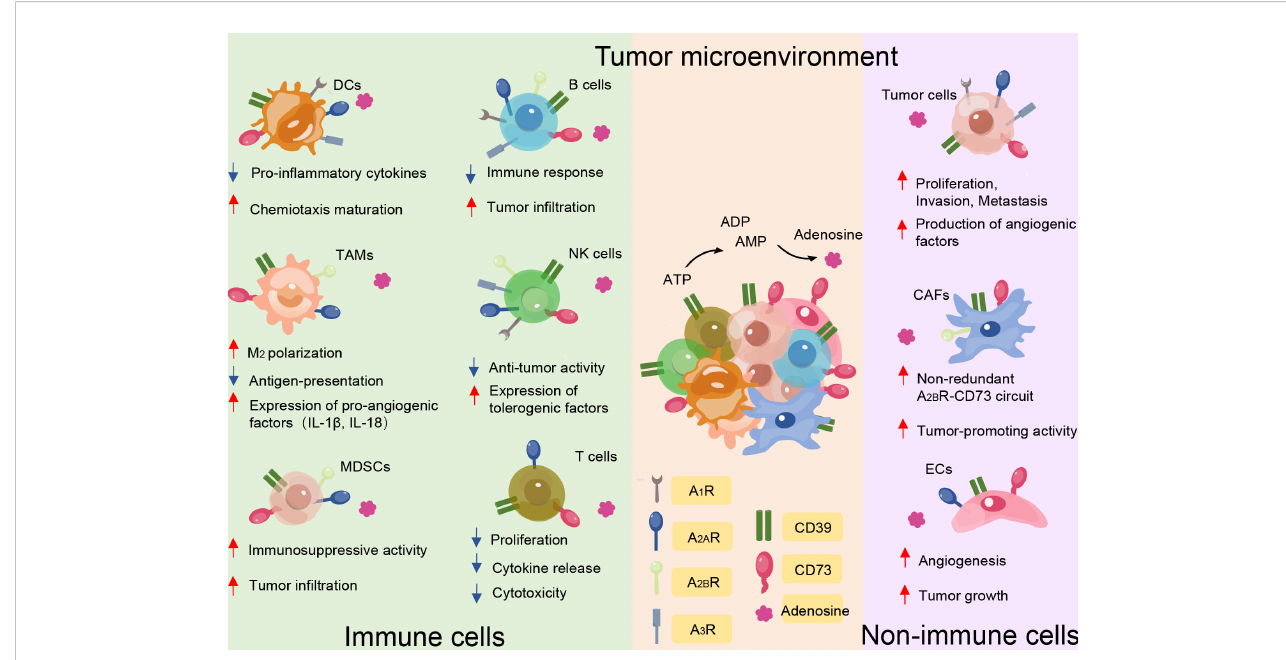
FIGURE 2 CD39 and CD73 serve as major immune suppressive mediators in the tumor microenvironment mainly through the generation of eADO. Besides the effect of ectonucleotidases on tumor cell proliferation, angiogenesis, in fi ltration, and metastasis, CD39 and CD73 expression by immune cells and non- immune cells impairs anti-tumor immunity by suppressing the function of protective immune cells, including T cells, B cells, natural killer (NK) cells, dendritic cells (DCs), myeloid derived suppressor cells (MDSCs), and tumor-associated macrophages, while maintaining the function of non-immune cells, including tumor cells, cancer-associated fi broblasts (CAFs), and endothelial cells (ECs). The red and blue arrows indicate whether functions are enhanced or reduced by adenosine binding to the different receptor